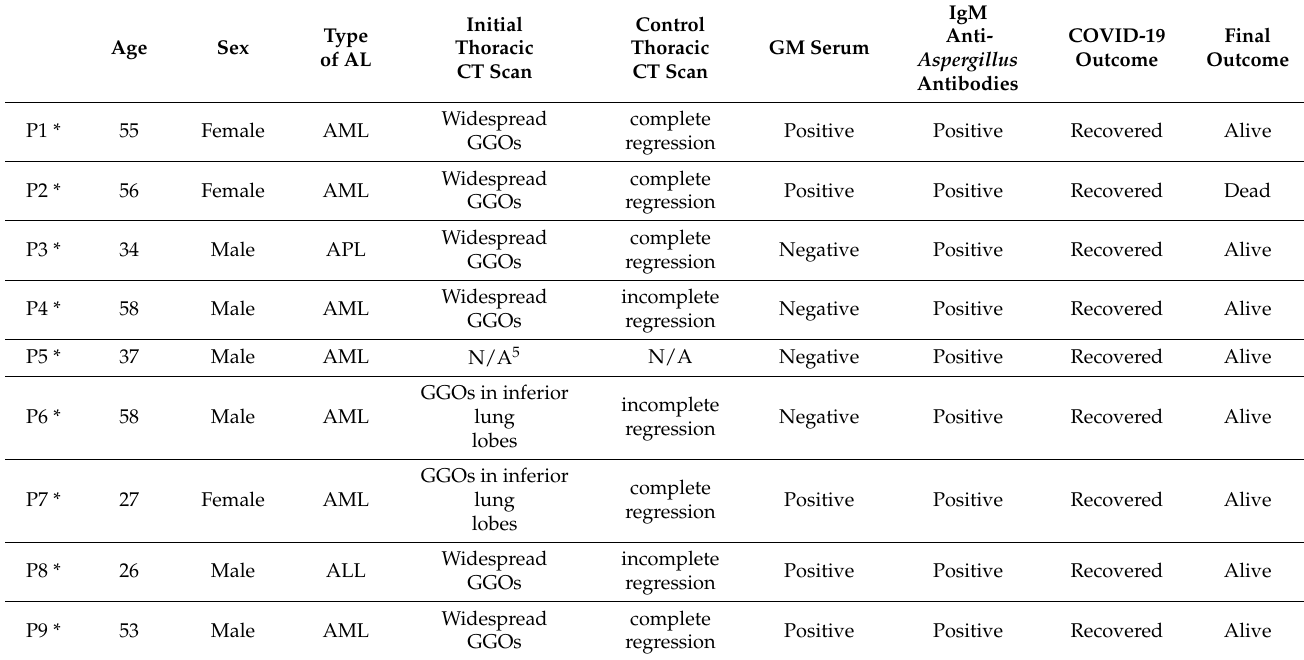
Table 1. Main patients’ characteristics, thoracic CT scans comparisons, serology and galactomannan (GM) detection in serum,